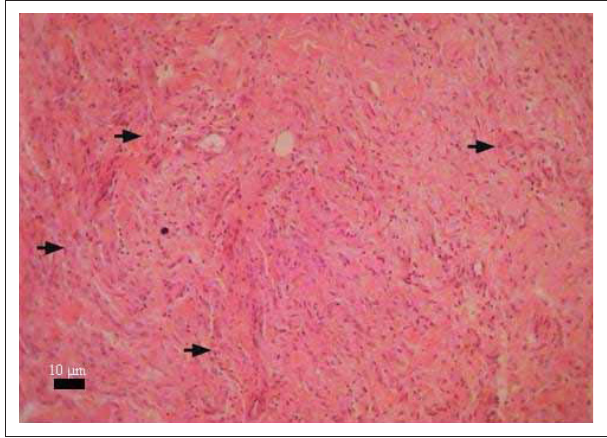
FIGURE 4: Wavy cellular pattern (arrows) with spindle cells and collagen fibres. Sample stained with haematoxylin and eosin and shown here at 160× magnification.